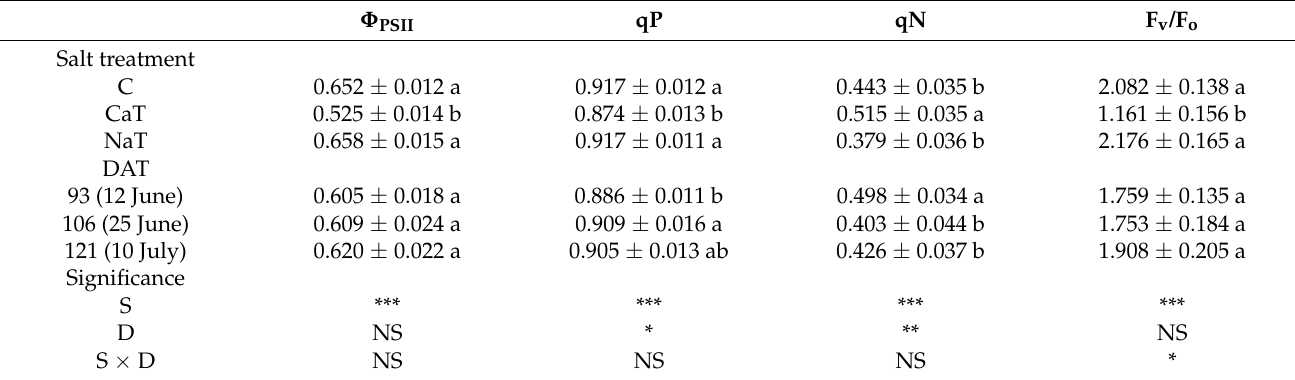
Table 3. Effects of salt treatment on the quantum yield of PSII electron transport ( Φ PSII ), photochemical quenching (qP), non-photochemical quenching (qN) and maximum quantum yield of PSII photochemistry (F v /F 0 ) in C. citrinus plants. Mean values and standard errors are shown. Different letters correspond to significantly different values ( p <